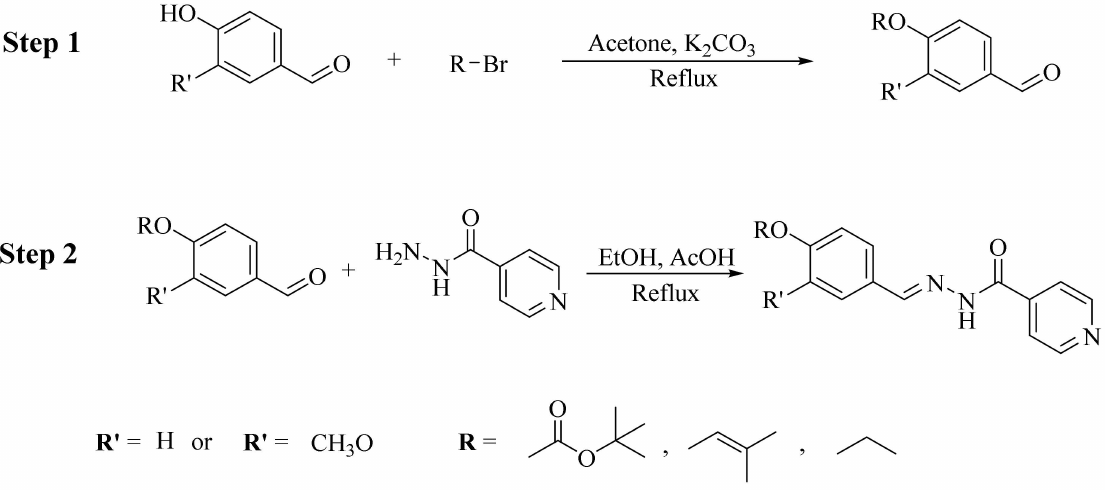
Figure 2. Synthesis of alkylated isoniazid derivatives. Table 1. Physical data of the synthesized compounds.